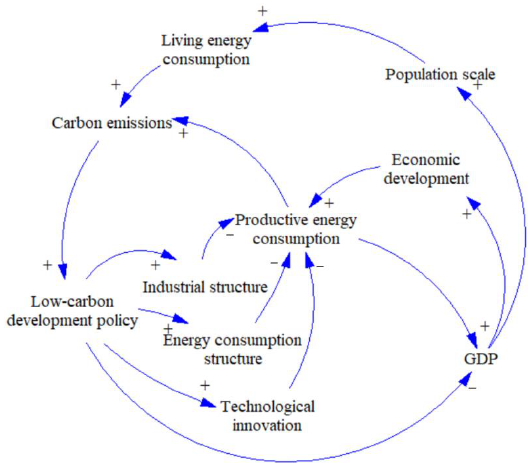
Figure 1. China’s carbon emission system: causality